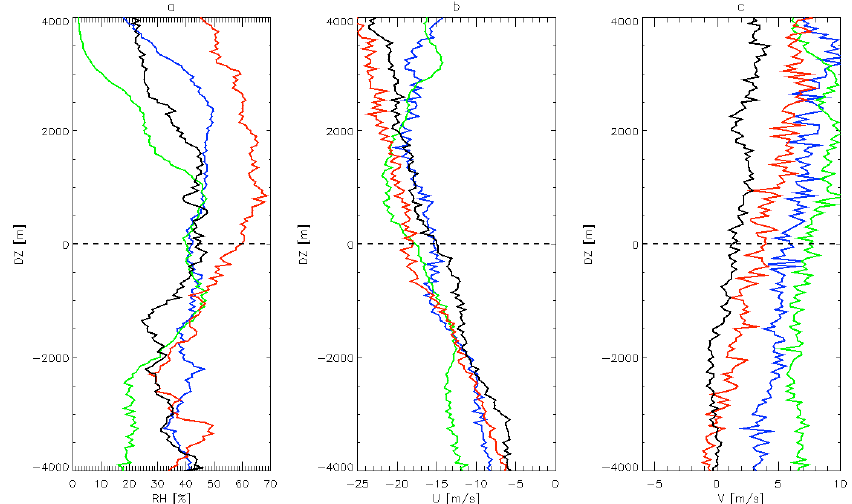
Figure 7. Mean profiles of relative humidity (RH), zonal (U) and meridional (V) wind components (plot a, b and c, respectively) as function of the relative height regarding the cirrus lower boundary (horizontal dashed black line). Colored curves represent the different cirrus classes (black, blue, red, and green curves for classes I, IIa, IIb and III, respectively).